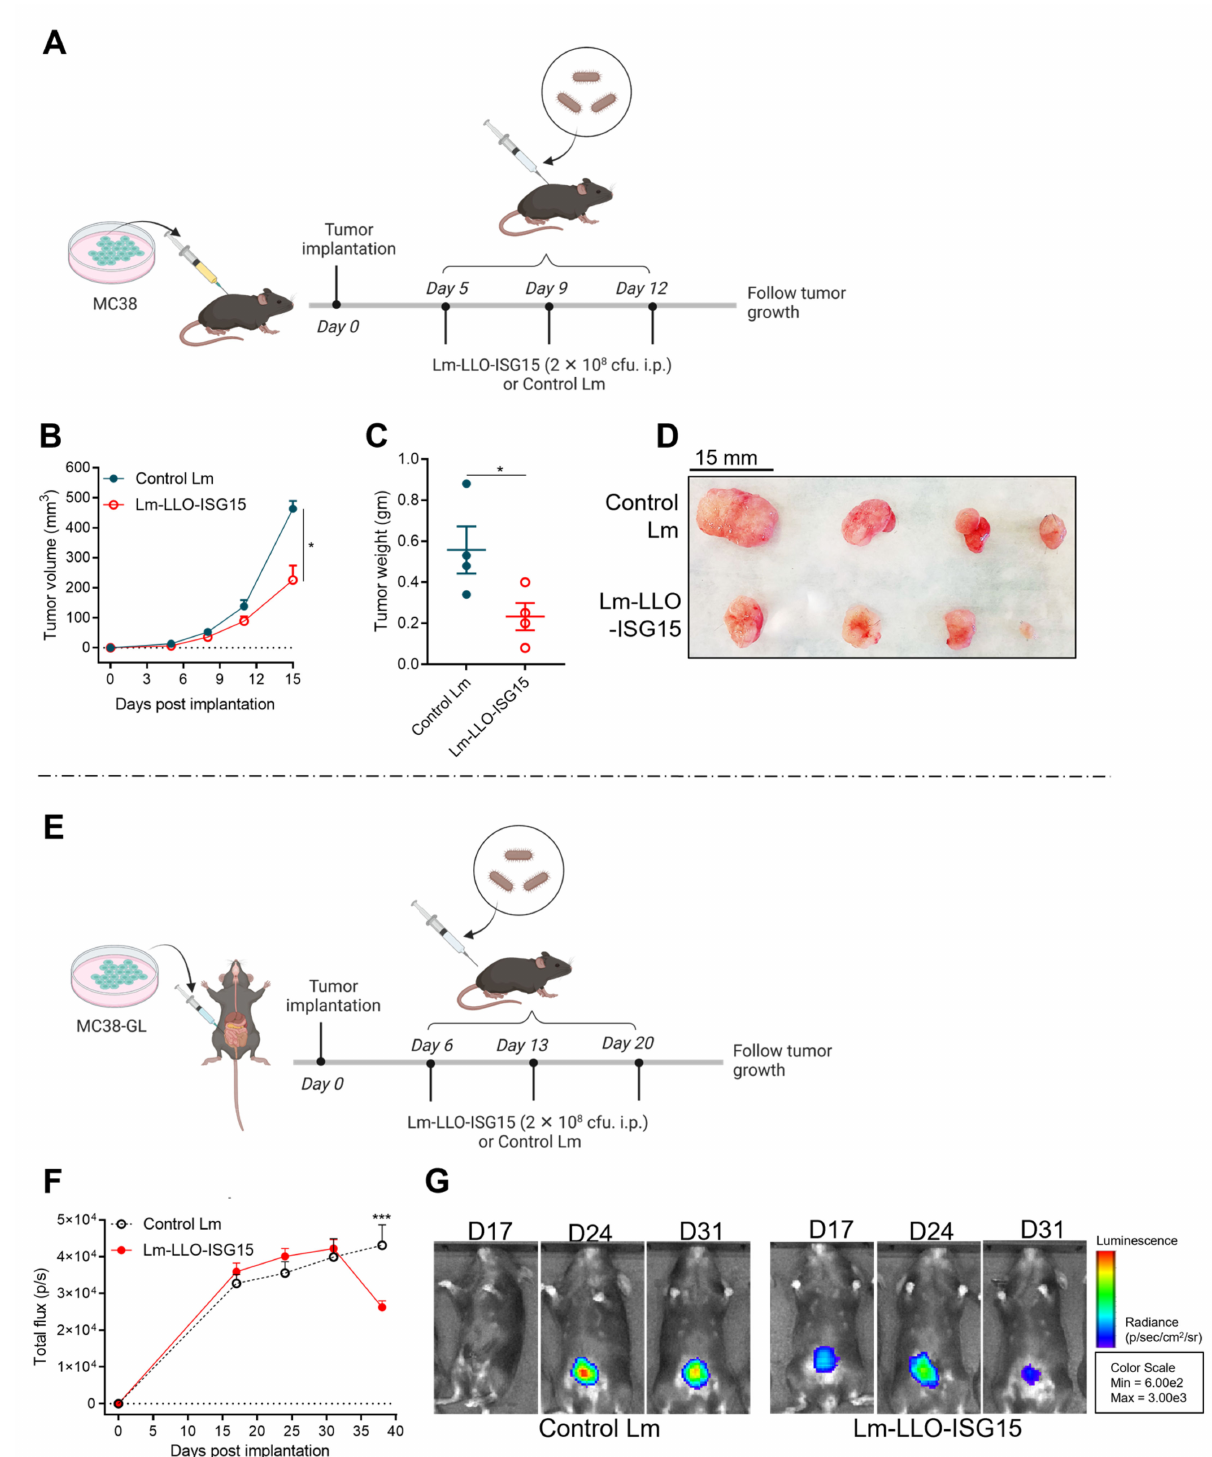
Figure 5. Therapeutic efficacy of Lm-LLO-ISG15 versus Control Lm in subcutaneous and orthotopic mouse models. ( A ) Experimental schema for subcutaneous model (made by BioRender). ( B ) Tumor growth kinetics (n = 4 in each group) and ( C , D ) final tumor mass. ( E ) Experimental schema for orthotopic model (made by BioRender). ( F ) Tumor growth kinetics (n = 8 in each group) and ( G ) representatives of tumor growth by bioluminesce signals on day 17, 24, and 31. Data were analyzed using unpaired t -test. All error bars are shown as mean ± SEM. * p < 0.05 and *** p <